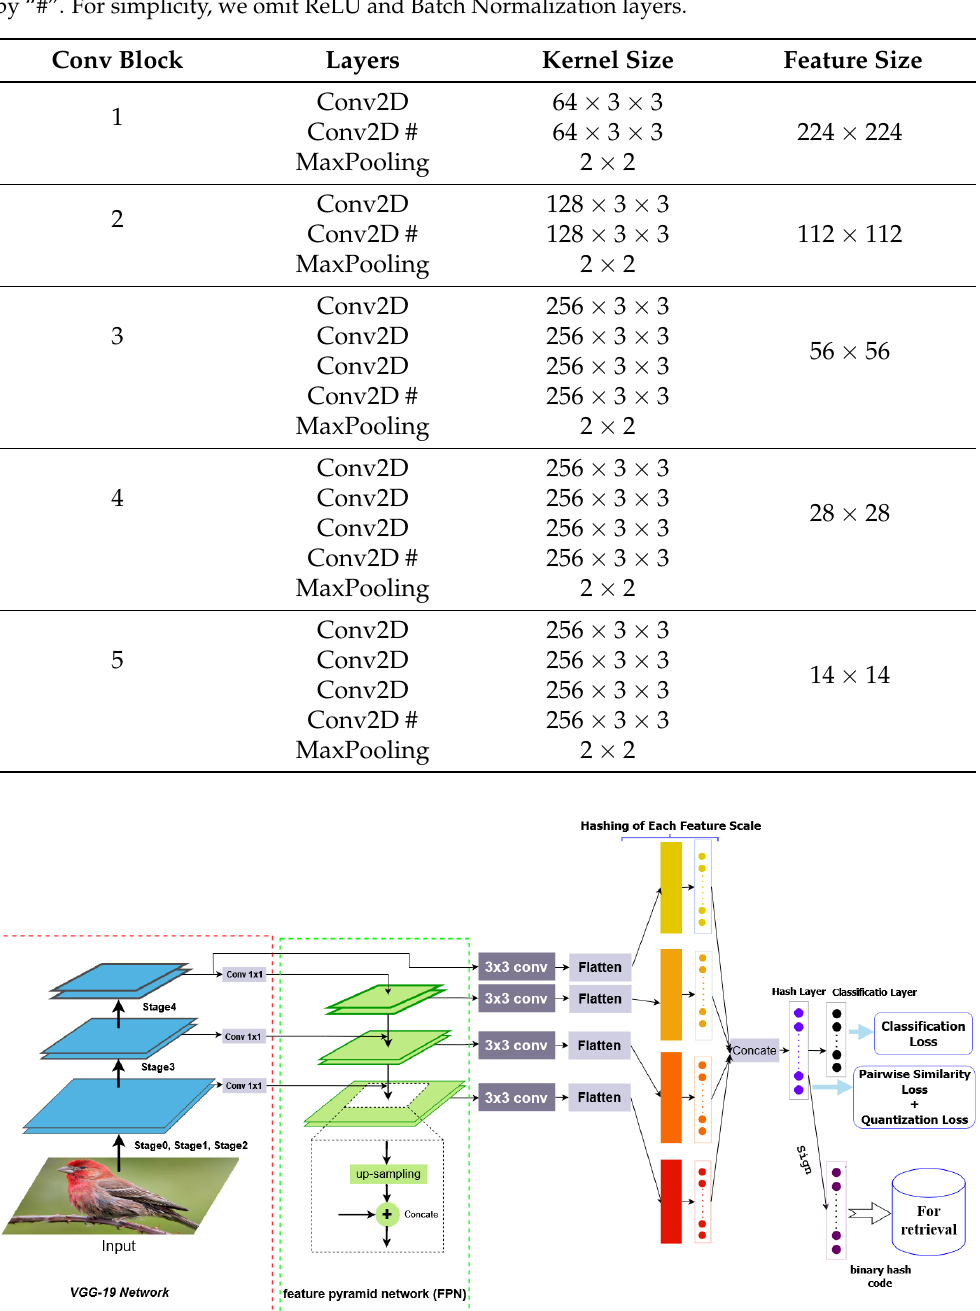
Figure 1. This figure shows our proposed model: Deep Feature Pyramid Hashing (DFPH), which uses VGG19 as the backbone and uses the feature pyramid network (FPN) and the created layers for